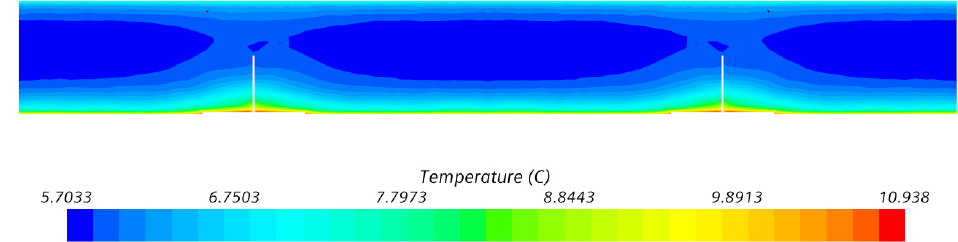
Figure 15. Visualization of façade temperature field—horizontal cross-section at height of 10 m winter extreme.